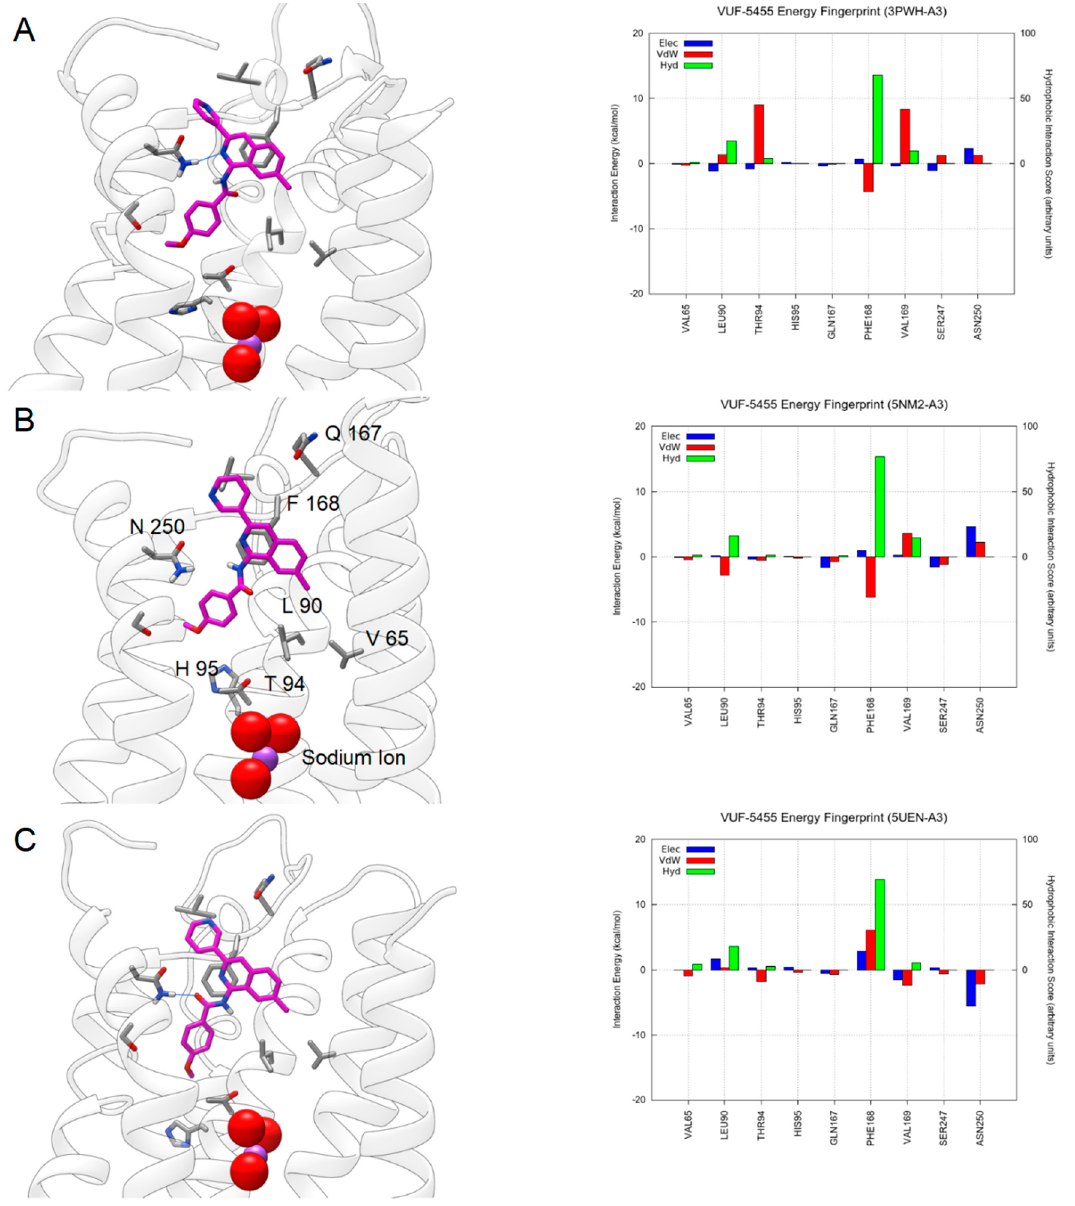
Figure 11. Per-residue energy histograms and selected docking poses of VUF-5455 on either the hA2A-based models ( A , B ) or the hA 1 -based model ( C ).